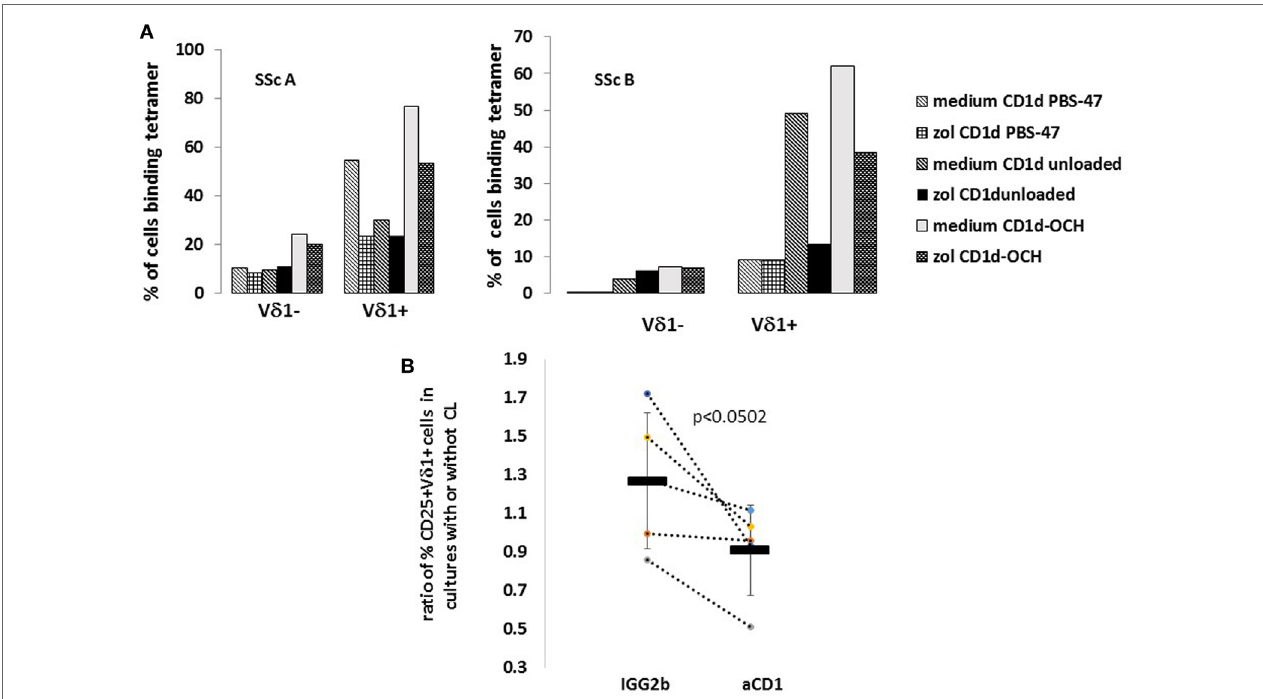
FigUre 5 | CD1d involvement in activation of V δ 1 + T cells by zoledronate (zol) and cardiolipin (CL) in systemic sclerosis (SSc) patients and healthy controls (HCs). (a) Peripheral blood mononuclear cells (PBMCs) from two SSc patients (SScA and SScB, patients 11 and 12; Table 1 ) were cultured in FMIL-2 alone (medium), or with 2 µM zol for 3 days, then co-stained with indicated antigen-presenting cell-labeled tetramers (CD1d unbound, CD1d PBS-47, and CD1d-OCH) and monoclonal antibody (mAb) to V δ 1-FITC, as described in figure. Bars show percent of cells binding the specific tetramers indicated in the legend within V δ 1 − and V δ 1 + cells in the cultures. (B) PBMC of five SSc patients (patients 8–12; Table 1 ) were cultured for 4 days with zol (2 µM) with or without CL (2.5 µg/ml), in the presence of a control non-binding mAb IgG2b or a mAb to CD1d. Subsequently, the expression of CD25 on the V δ 1 + T cells was assayed by flow cytometry and the %CD25 + V δ 1 + calculated. The y axis represents the ratio of %CD25/V δ 1 + T cells in cultures with and without CL. Each dot represents an individual patient; results in the presence of the different mAb are connected by dotted lines. Means of values in the presence of control mAb and anti-CD1d are represented by horizontal bars; 1 SEM is indicated by vertical bars. p Value comparing means (Student’s one-tailed t -test) is